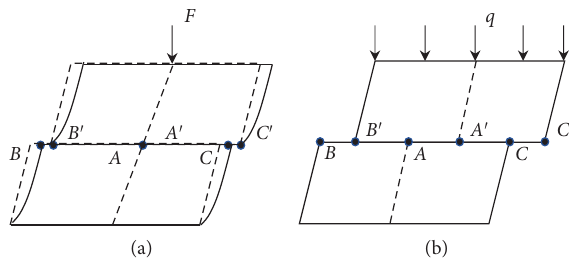
Figure 20: The connected type of section. (a) Elastic creep. (b) Interface